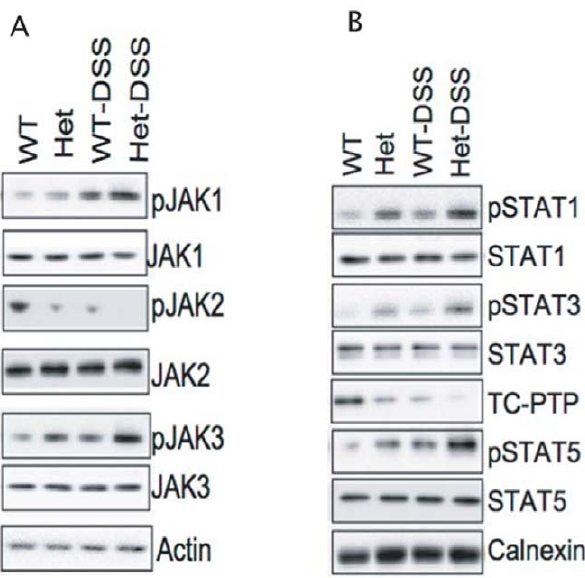
Figure 4. Jak/Stat signaling pathways. Immunoblotting was used to observe total protein levels and protein phosphorylation levels of JAK1, JAK3, STAT1, STAT3 and STAT5.